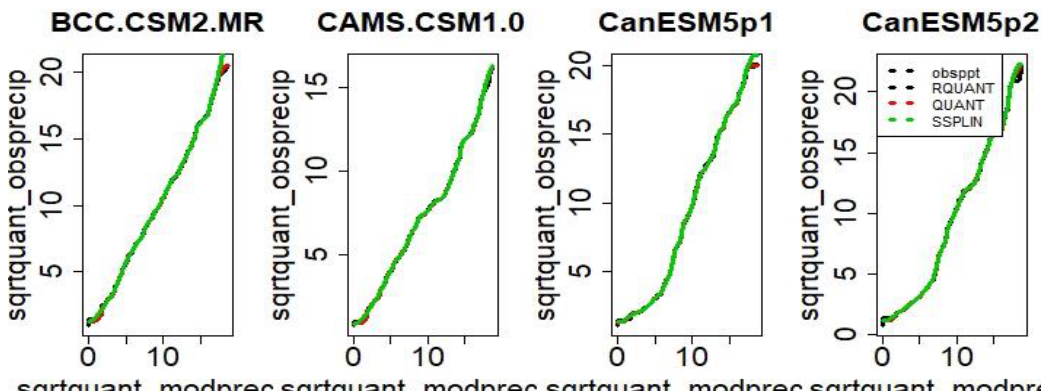
Figure A1. Square root quantile–quantile mapping of model precipitations (BCC-CSM2-MR, CAMS-CSM1-0, CanESM5p1 and CanESM5p2) versus GPCC monthly observation precipitation.